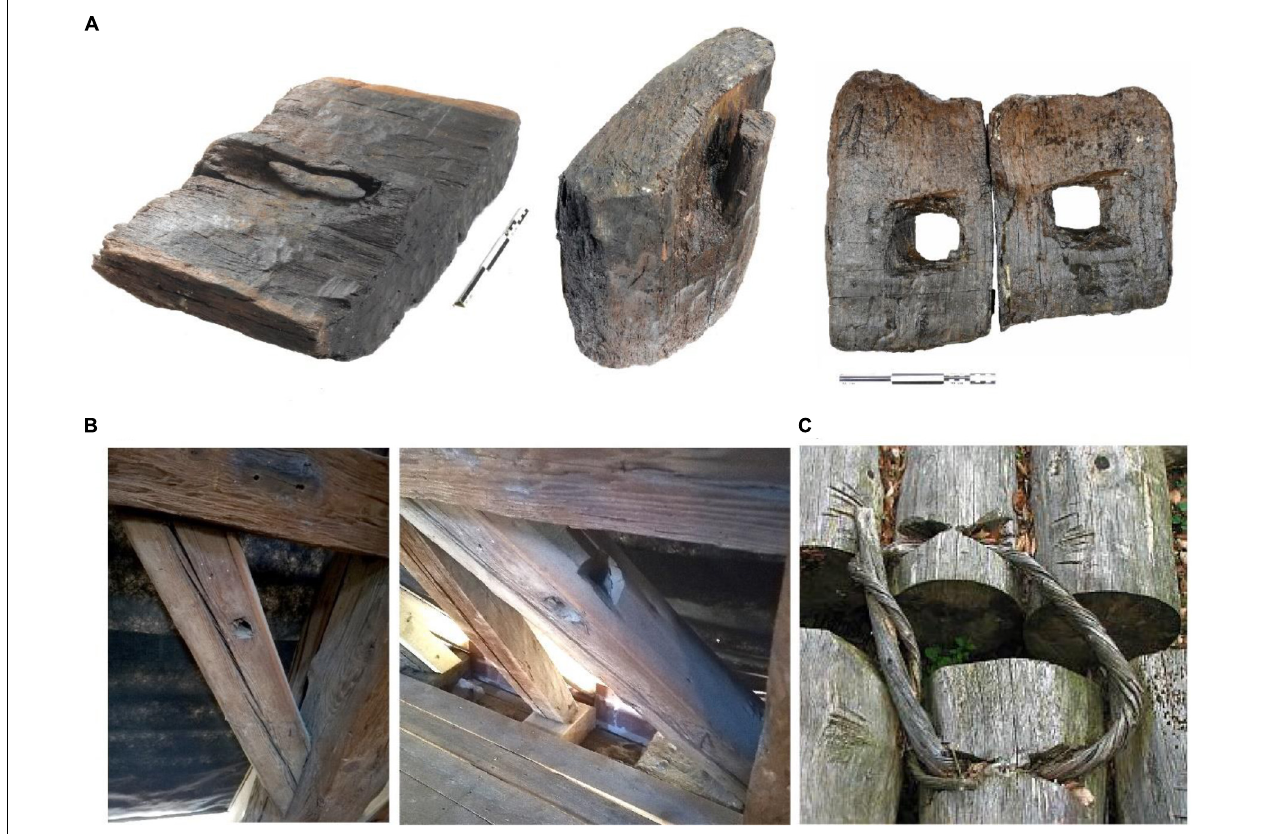
FIGURE 10 | (A) Oak posts from a Neolithic palisade (3231 BCE) with recesses on the basis used for timber floating or over land transport (Donnart et al., 2019). (B) Recesses on construction wood frequently found in roof trusses (Colmar, Alsace, France, 18th century CE) typical for timber rafting. (C) Detail view on the raft assemblage of a modern reconstructed